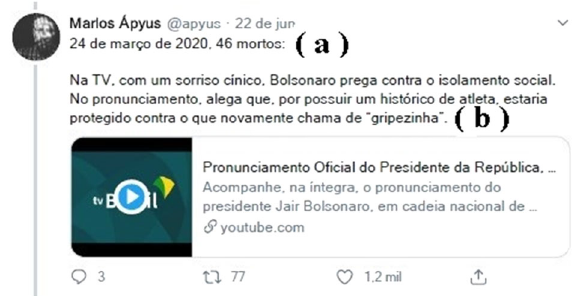
Fig. 1 On Twitter, a journalist ’ s commentary points to how Bolsonaro has been framing the virus. Translation (a) 24 March, 2020: 46 deaths. Translation (b) On TV, with a cynical smile, Bolsonaro preaches against social distancing. In his pronouncement, he claims that, for having a background as an athlete, he would be protected against what he, again, calls “ a little fl u ”